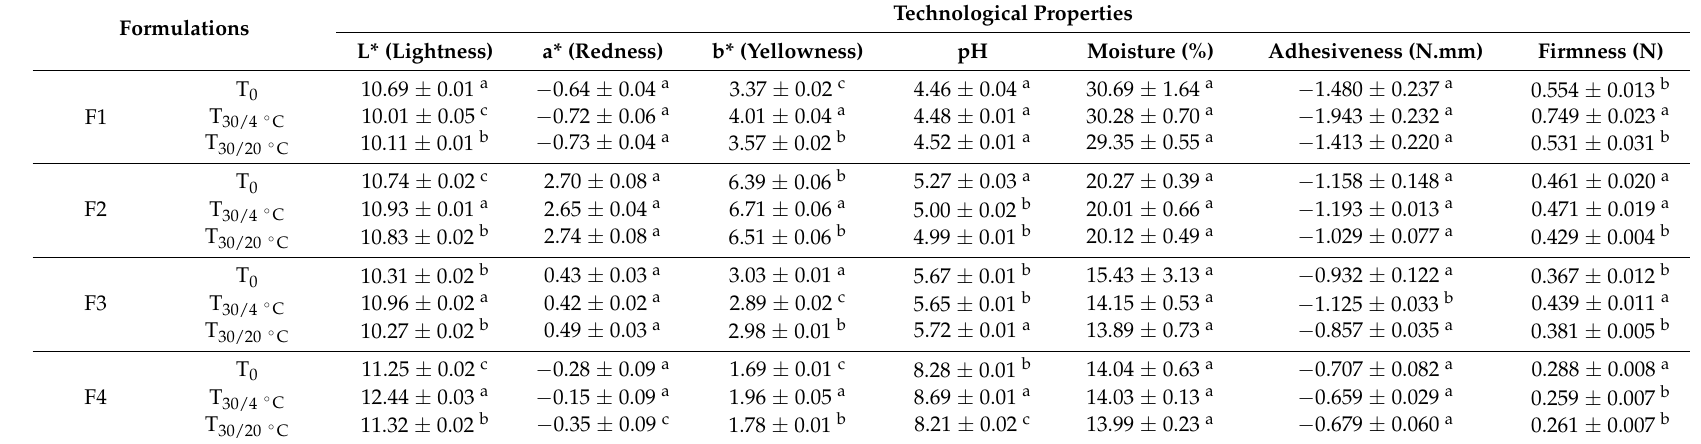
Table 2. Colour variation (L*, a* and b*), pH, moisture and texture (adhesiveness and firmness) of hydrogels containing chestnut bur extracts in different percentages, evaluated at different times and temperatures (mean ± standard deviation, n = 3). T 0 , time 0. T 30/4 ◦ C , after 30 days at 4 ◦ C. T 30/20 ◦ C , after 30 days at 20 ◦